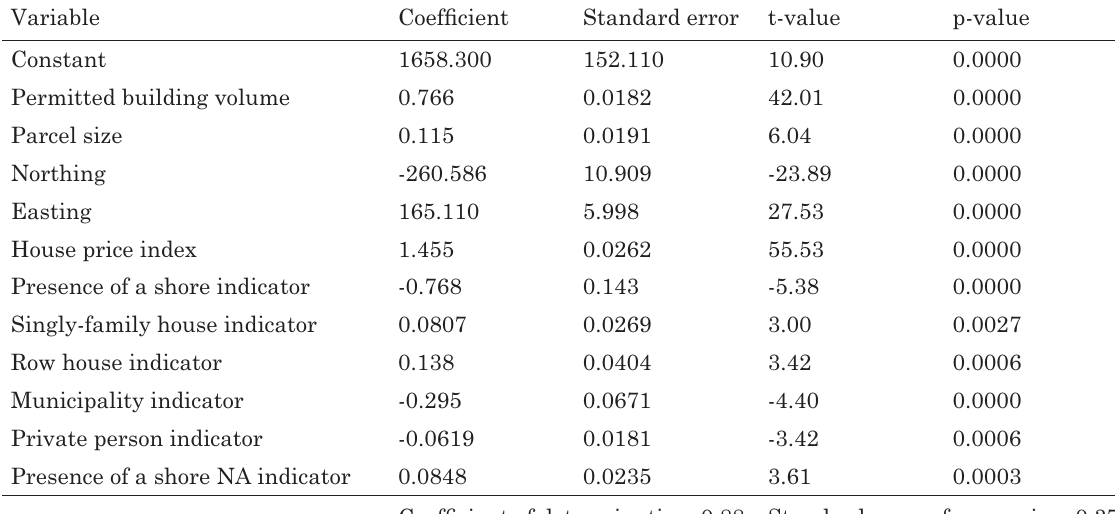
Table 2. Fit and hedonic prices from the ordinary least squares